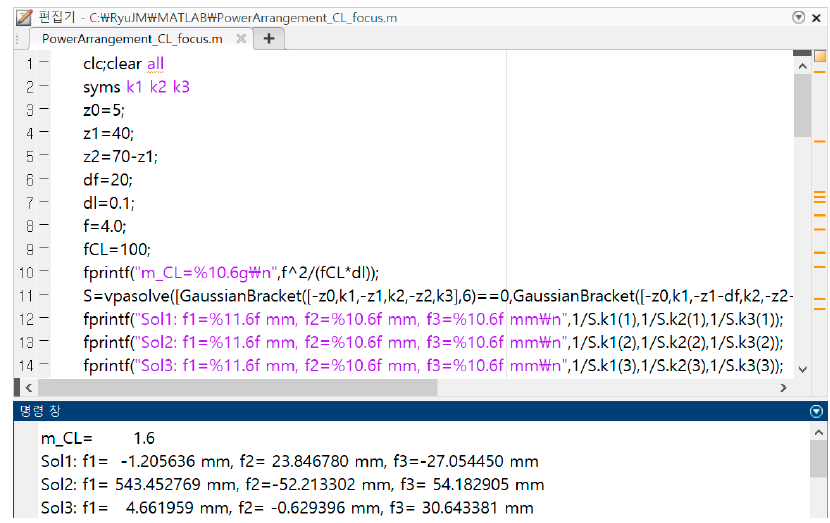
Figure 3. Result from solving Equations (1), (2), and (6) in a series of solutions using MATLAB